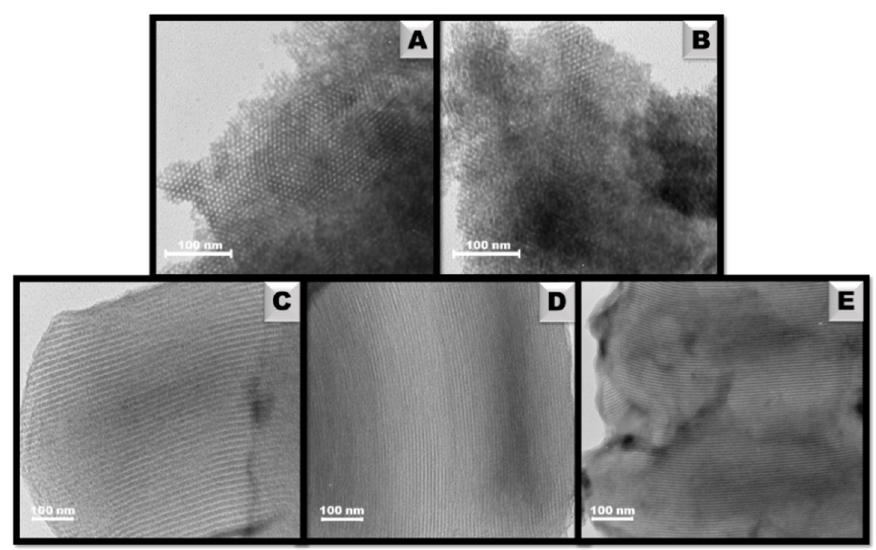
Figure 3. TEM images of ordered mesoporous carbons: C AP-L ( A ), C AP-H ( B ) cross-section revealing hexagonal honeycomb order; C SBA-15 ( C ), C CH-L ( D ), and C CH-H ( E ) side view showing independent cylindrical channels.